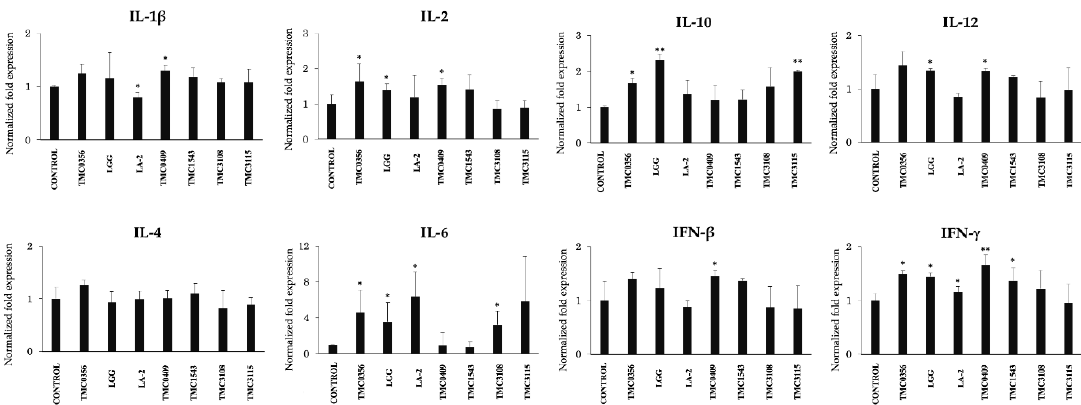
Figure 13. Immunobiotic mediated inflammatory responses in the antigen presenting cells (APCs) of Payer’s patches. The APCs were seeded at 1 × 10 6 cells / well of 6-well plate and cultured with each bacterial strain (5 × 10 8 cells / well) separately for 24 h and the mRNA expressions of IL-1 β , IL-2, IL-4, IL-6, IL-10, IL-12, IFN- β and IFN- γ ) were analyzed with RT-qPCR. Data shown are the mean ± SD of 3 independent experiments performed in triplicates. The asterisks: (*) and (**) indicated statistical di ff erences with significant levels of p < 0.05 and p < 0.01, respectively. TMC0356, Lactobacillus gasseri TMC0356; LGG, L. rhamnosus GG; LA-2, L. rhamnosus LA-2; TMC0409, L. paracasei TMC0409; TMC1543, Streptococcus thermophilus TMC1543; TMC3108, Bifidobacterium bifidum TMC3108; TMC3115, B. bifidum TMC3115.